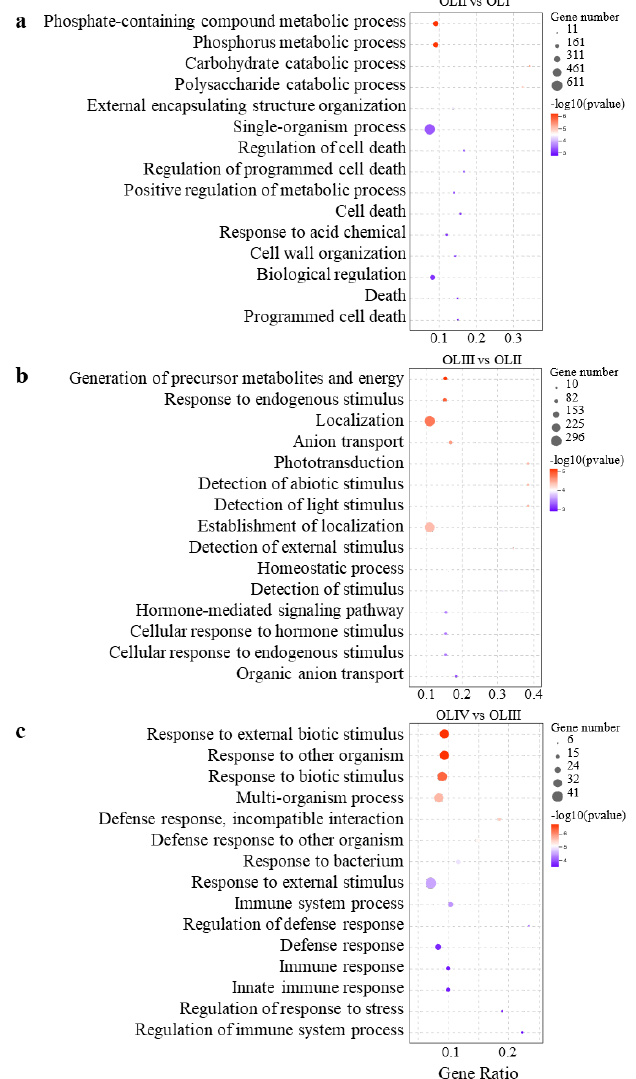
Figure 4. Top 15 significance level GO terms in OLII vs. OLI ( a ), OLIII vs. OLII ( b ) and OLIV vs. OLIII ( c ) comparisons.